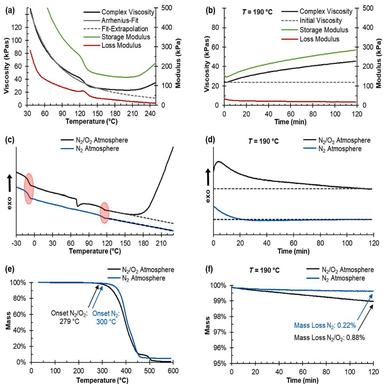
Analysis of the temperature stability of CSP1. The left column shows temperature sweeps in different temperature ranges, while the right column shows data obtained from isothermal measurements at 190 ◦C for 120 min. (a) Temperature-dependent rheological measurements under ambient atmosphere. In a temperature range from 35 ◦C to 165 ◦C measured viscosities were fitted to an Arrhenius-Law and extrapolated for higher temperatures. (b) Isothermal rheological examination under ambient atmosphere. The minimum vis